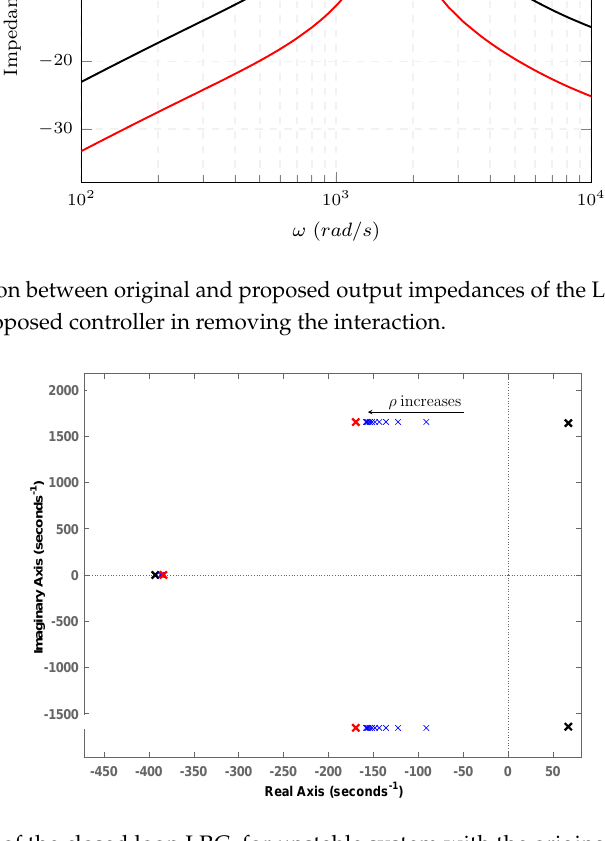
Figure 10. Pole loci of the closed loop LRC, for unstable system with the original control at full load (black poles), original control at no load (red poles), and proposed control (blue poles), highlighting the decoupling capability, as a function of ρ .